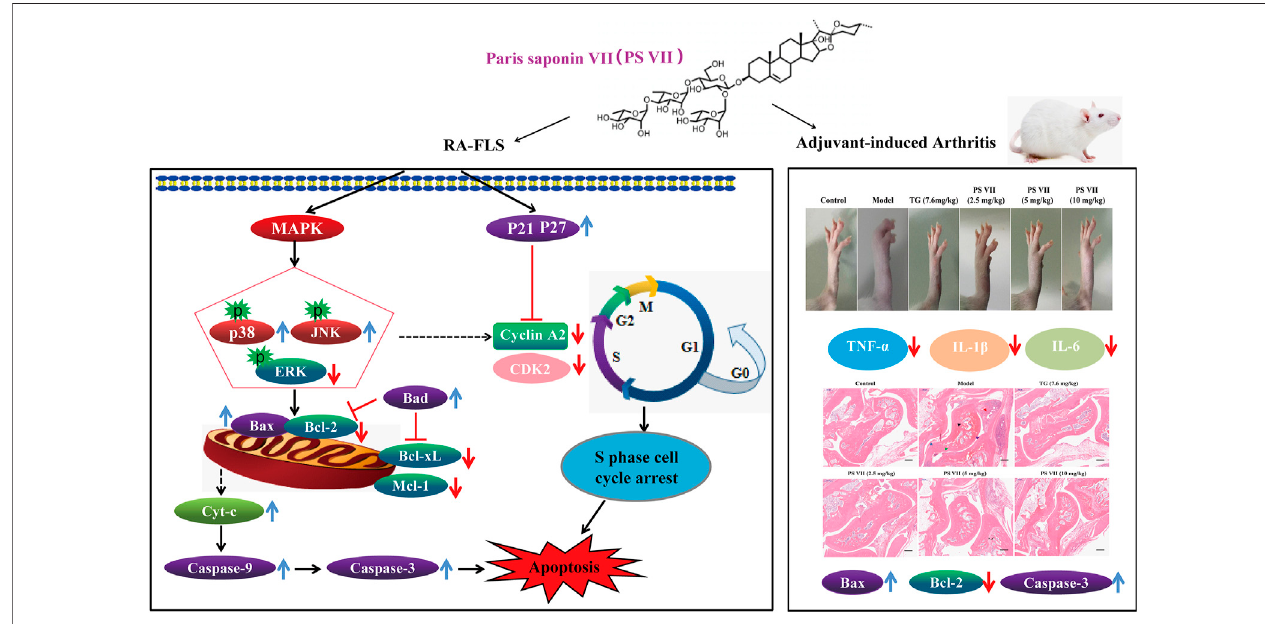
FIGURE 13 | Schematic representation of proposed mechanism responsible for PS VI-mediated treatment of rheumatoid arthritis.